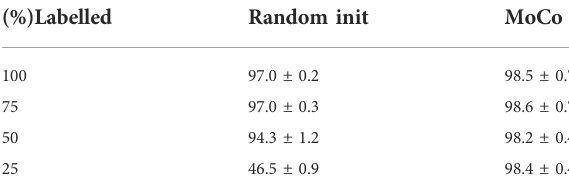
TABLE2Comparisonofsubtomogramclassi fi cationaccuracy(%)with standard deviation on real data. Classi fi ers with CSSL pretrained initial weights always perform better than classi fi ers with random initial weights proving the ef fi cacy of CSSL